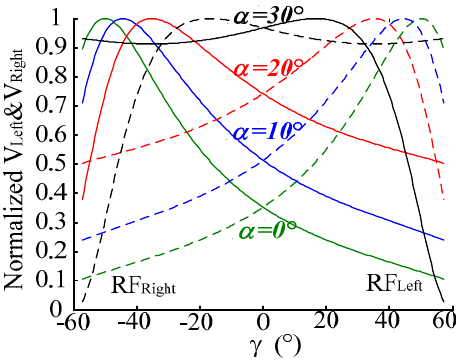
Figure 6. Normalized characteristic curve of V Right and V Left when γ changes. ( α is 0°, 10°, 20°, 30° respectively, p is 0 μ m, h is 500 μ m).